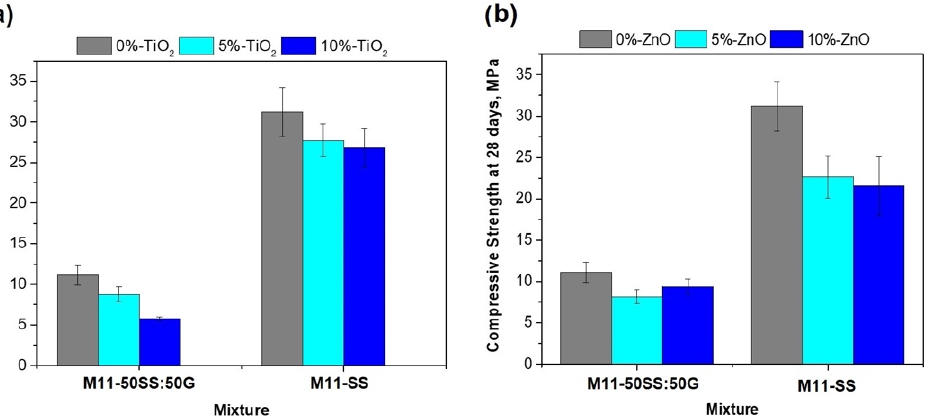
Figure 7. Compressive strength for pastes with incorporation of ( a ) TiO 2 and ( b ) ZnO particles. Table 5. Density of mixtures with incorporation of TiO 2 and ZnO particles. Density, kg/m 3 Mixtures